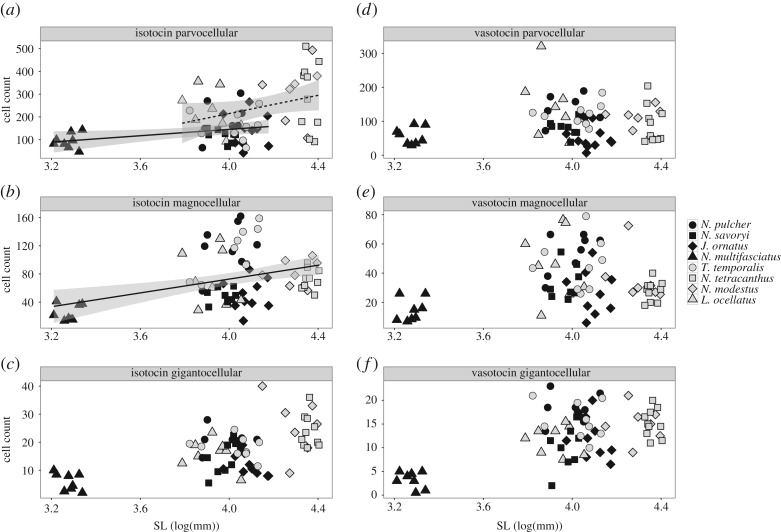
Isotocin (a–c) and vasotocin (d–f) cell counts plotted against standard length (SL) for each of eight species of lamprologine cichlid fishes. Black symbols represent cooperatively breeding species; grey symbols represent independently breeding species. Fit lines indicate a significant relationship between body length and cell count (PMCMC < 0.05) while separate fit lines for cooperatively (solid line) and independently (dashed line) breeding species indicate a social system difference in cell count (PMCMC < 0.05).